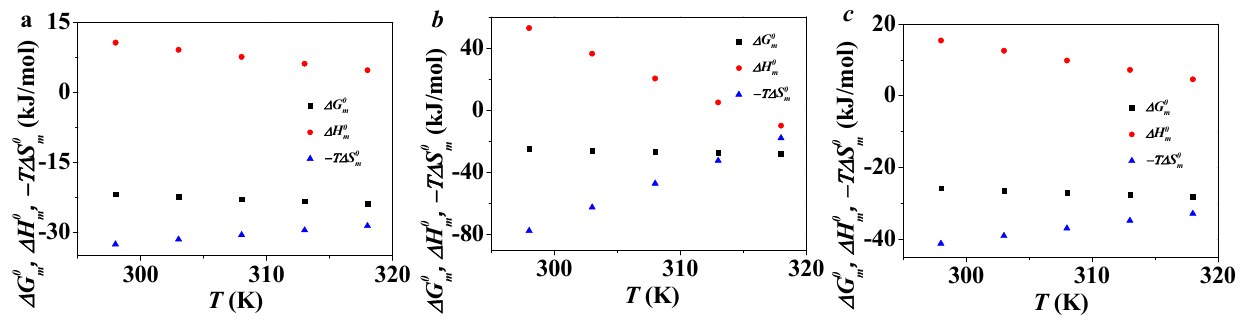
Figure 6. Plots of (cid:1986)(cid:1833) (cid:3040)(cid:2868) , ∆(cid:1834) (cid:3040)(cid:2868) and −(cid:1846)∆(cid:1845) (cid:3040)(cid:2868) versus T for C 12 MDB ( a ); C 14 MDB ( b ); and C 16 MDB ( c ).